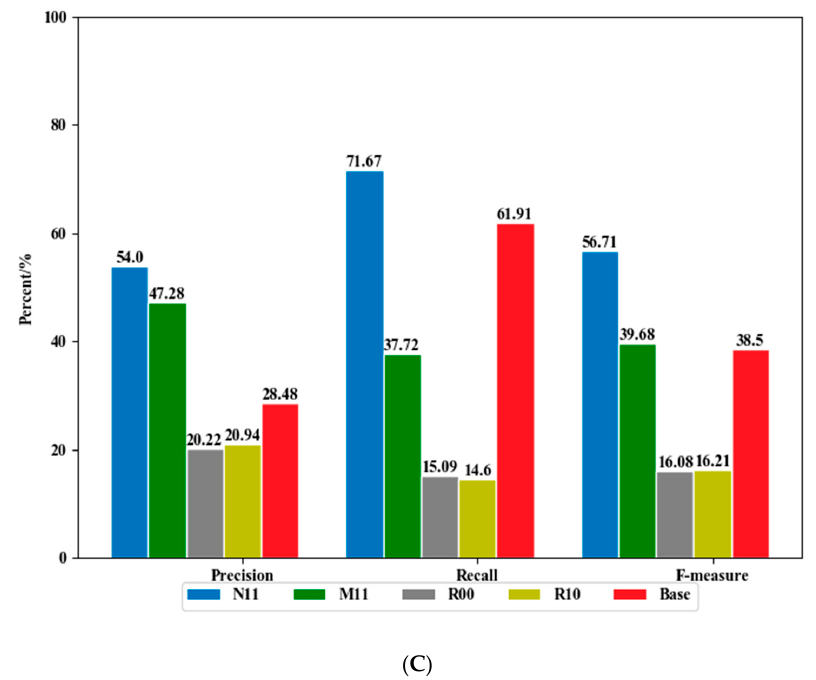
Figure 6. Performance of the root cause identification (RCI)-NWS and RCI-MF methods. ( A ) Comparative performance of RCI-NWS methods in different conditions; ( B ) Comparative performance of RCI-MF methods in different conditions; ( C ) Comparative performance among best performances in RCI-NWS, best performances in RCI-MF, Raw and Base.